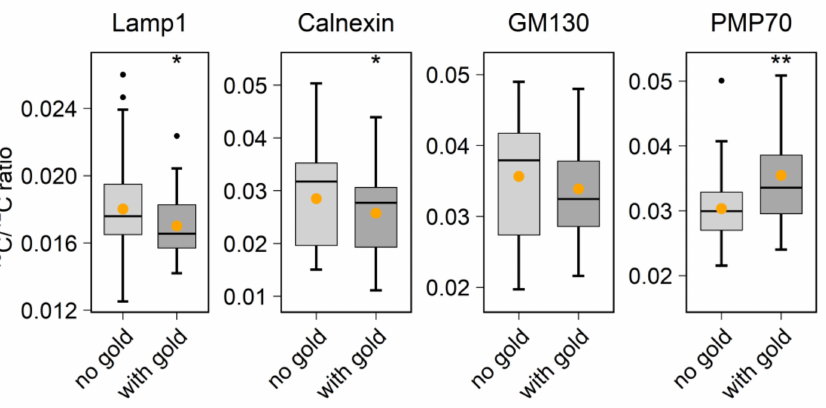
Figure 5. Detection of protein turnover heterogeneity in different organelles of 13 C isotopically enriched mouse brain slices. For each organelle marker staining, 13 C/ 12 C ratios were calculated for 6 nm Au_Np-labeled areas (with gold) and the random selection of multiple representative unlabeled areas (no gold). A difference in the relative protein “age” in different organelles, in comparison to the average cellular protein “age”, is demonstrated by this approach. Wilcoxon rank sum test: for lamp1, calnexin, GM130 and PMP70 (no gold, with gold), N = (113, 41), (59, 80), (56, 40) and (47, 34), respectively, and p = 0.019, 0.044, 0.28 and 0.004, respectively. * p ≤ 0.05, ** p ≤